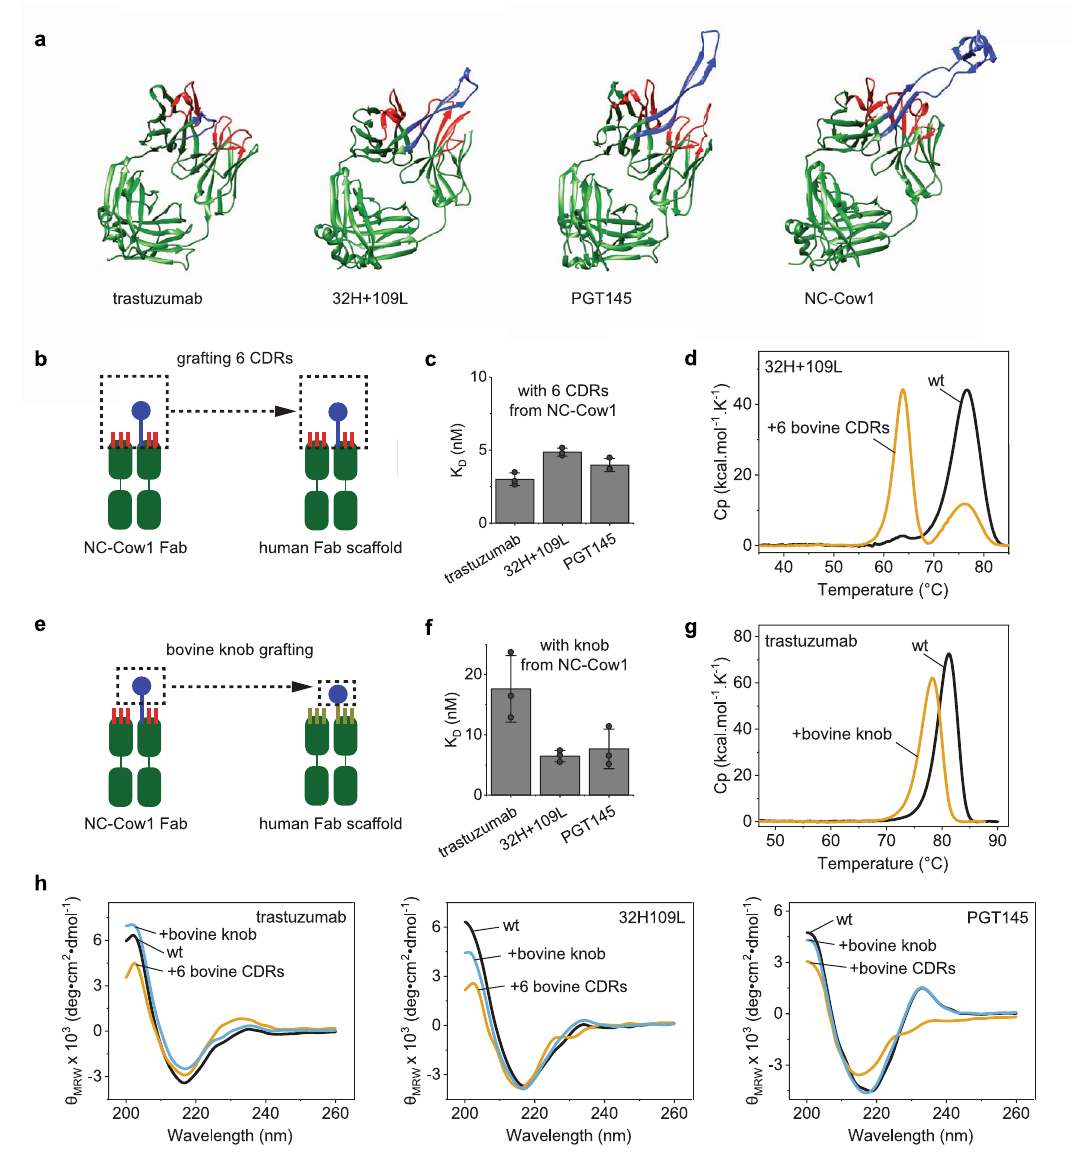
Fig. 3 Humanization approaches for bovine antibodies with ultra-long CDR-H3s. a A comparison between the 3D structures of human Fab scaffolds (trastuzumab (PDB: 6B9Z), 32H + 109L (PDB: 5CEX), PGT145 (PDB: 3U1S)) and NC-Cow1 Fab (PDB:6OO0). The CDR-H3 is colored in blue, the remaining CDRs are in red. b Humanization by transferring all 6 CDRs from NC-Cow1 to a human scaffold. The ultra-long cow CDR-H3 is in blue. The remaining fi ve cow CDRs are in red. The frameworks are in dark green. c Binding af fi nity of human Fabs with 6 bovine CDRs to the HIV-1 Env antigen in SPR (mean of triplicates with standard deviation). d Thermal stability of 32H + 109L with 6 cow CDRs compared to the parent human Fab. e Humanization by inserting the knob from NC-Cow1 in the tip of CDR-H3 of a human scaffold. The bovine knob is in blue. The remaining fi ve cow CDRs are in red. The human CDRs are in light green. The frameworks are in dark green. f Binding af fi nity of human Fabs with bovine knob insertions in CDR-H3 (mean of triplicates with standard deviation). g Thermal stability of trastuzumab with a knob insertion compared to the parent Fab. h FUV CD spectra of human and chimeric Fabs. Sequence alignments of the wt proteins and corresponding mutants can be found in supplementary data (Supplementary Fig 13). In g and h , black is the wildtype (wt) protein, blue is a mutant with a bovine knob grafted onto a human CDR-H3, orange is a mutant where all six human CDRs are exchanged for all six bovine